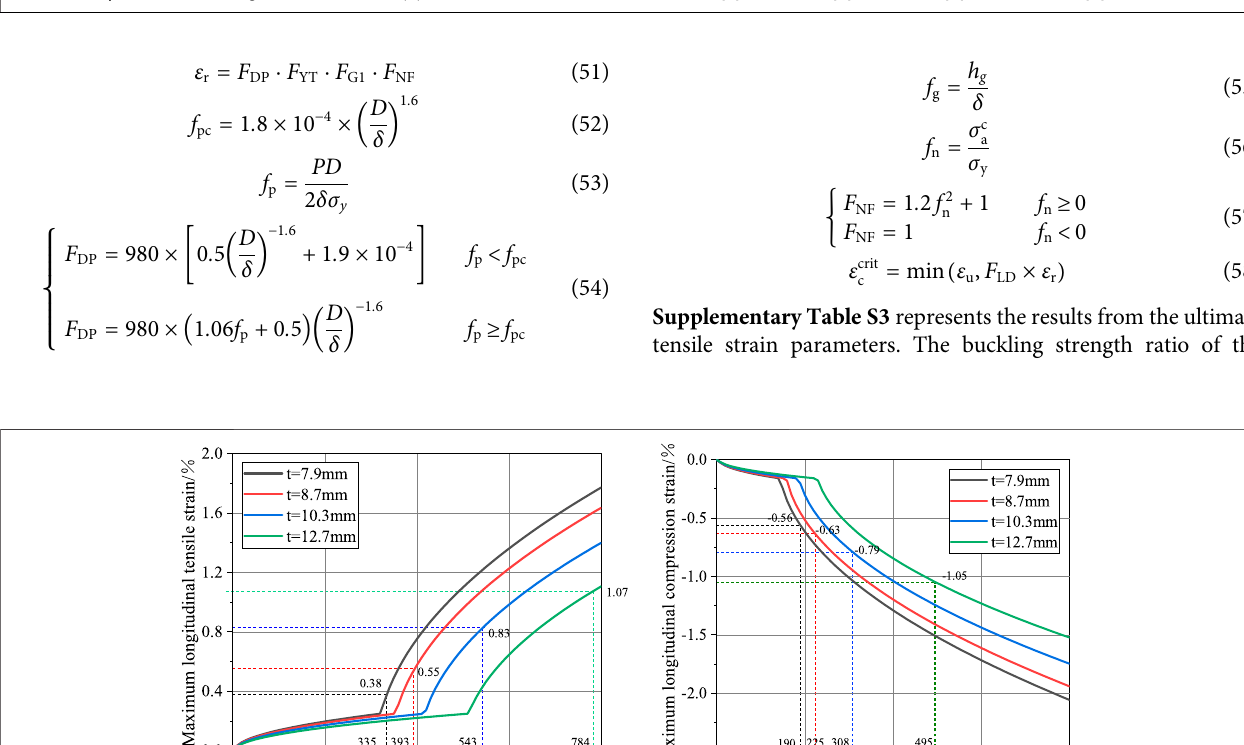
FIGURE 12 | The maximum longitudinal strain of the pipeline under the reference condition with (A) L (cid:1) 200 m, (B) L (cid:1) 300 m, (C) L (cid:1) 400 m and (D) L (cid:1) 500 m.